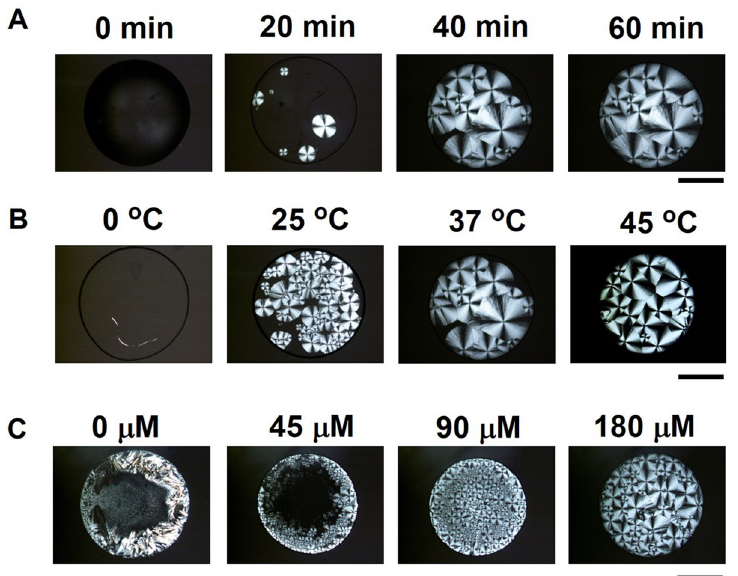
Fig 2. Formation of MT spherulites depending on time, temperature and concentration of tubulin dimers. (A) Time-lapse polarized optical microscopy images of MT spherulites. The tubulin solution was evaporated at 37 o C. (B) Growth of MT spherulites at different temperatures after 40 min of evaporation. The volume of tubulin solution was used 2 μ L for placing the droplets and concentration was 180 μ M. (C) Effect of concentration of tubulin solution (0 μ M, 45 μ M, 90 μ M and 180 μ M) on the formation of MT spherulites. The images were taken after 40 min of evaporation of the droplets at 37 ˚C. Scale bar: 1 mm.